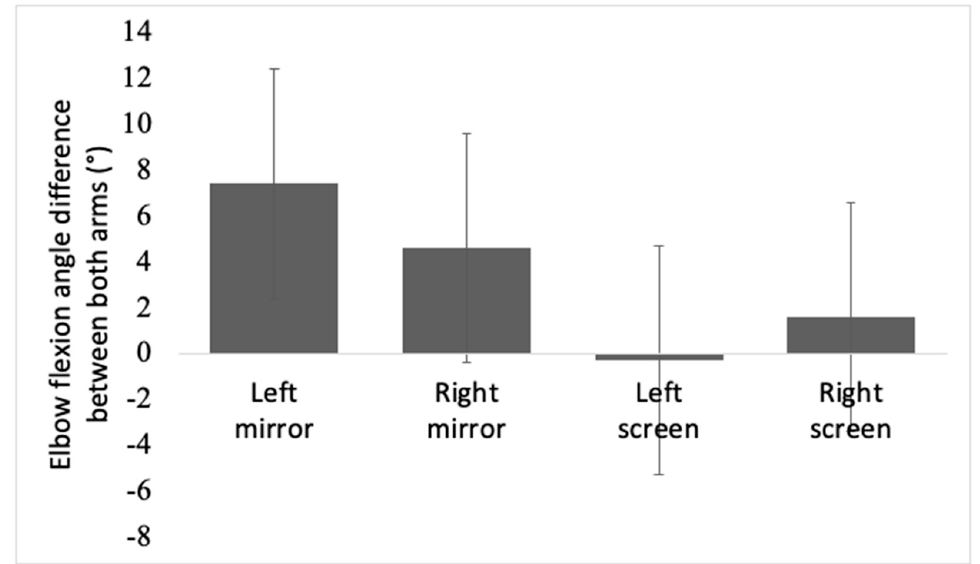
Figure 6. This bar chart shows elbow flexion angle difference between both arms during intervention in mirror and screen conditions. Asterisks represent statistical significance ( p < 0.05).